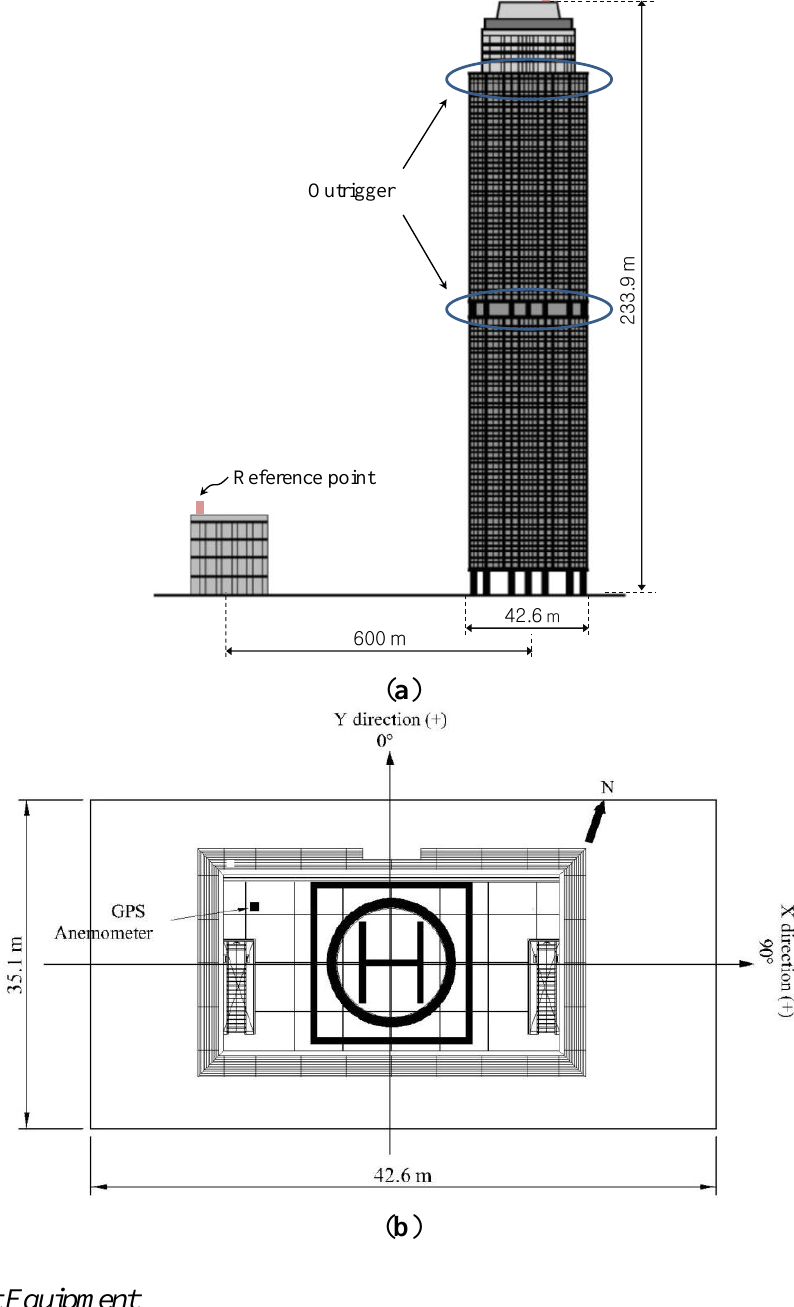
Figure 4. A 66-story building for full-scale test: ( a ) Locations of measuring point and reference point; ( b ) Measurement devices and coordinate